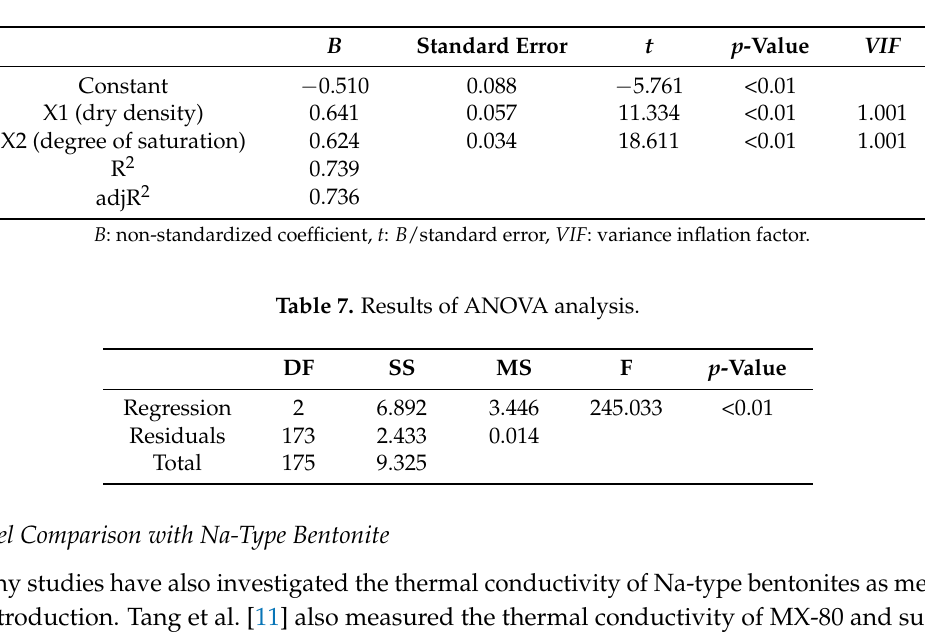
Table 6. Results of multiple regression analysis model for KJ-I.